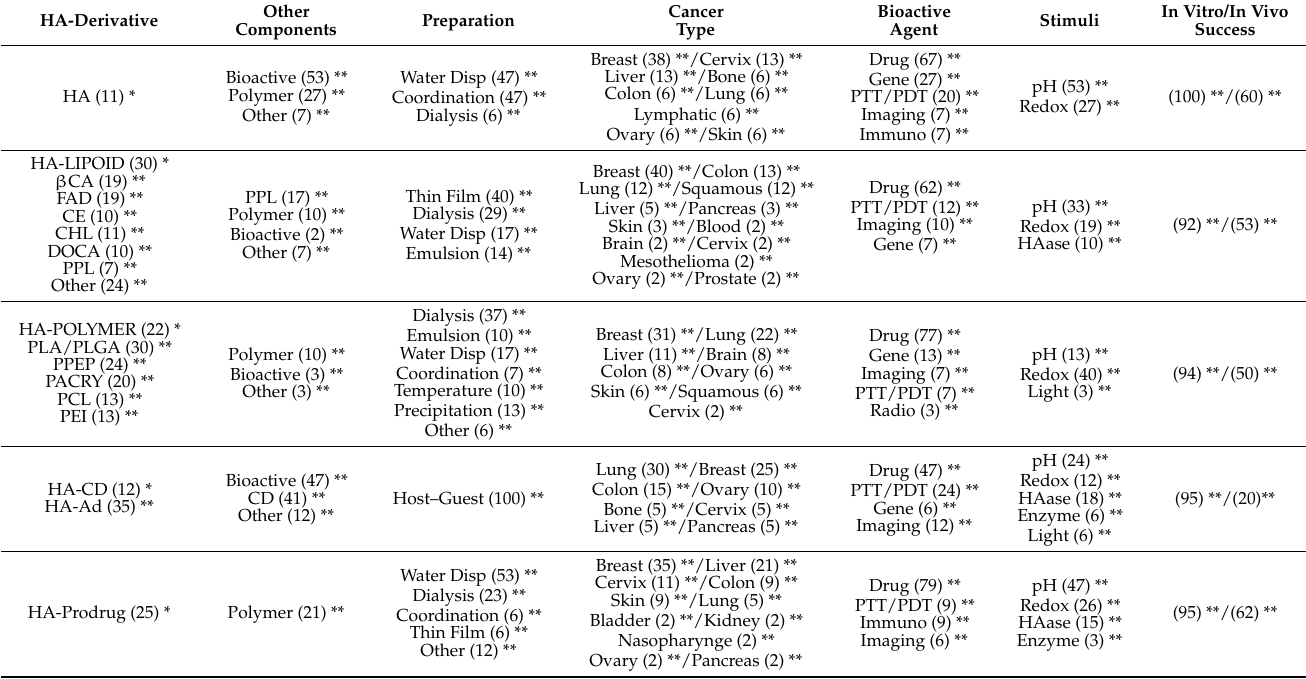
Table 8. Outcomes of HA-SANPs for cancer therapy expressed as (%) of the reviewed